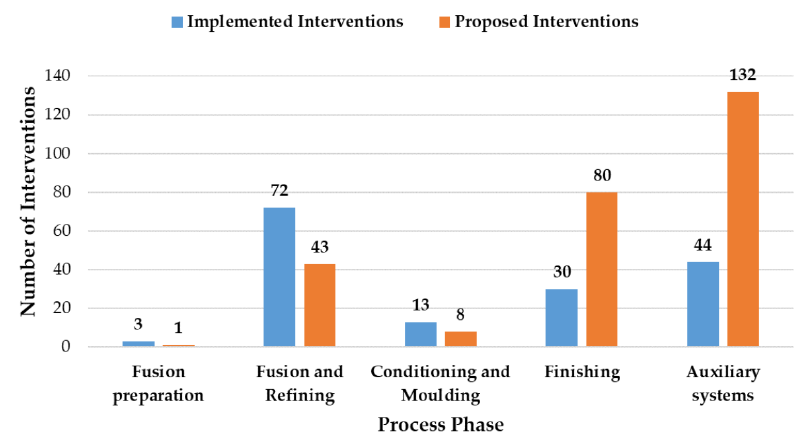
Figure 4. Interventions carried out and proposals by process phase.